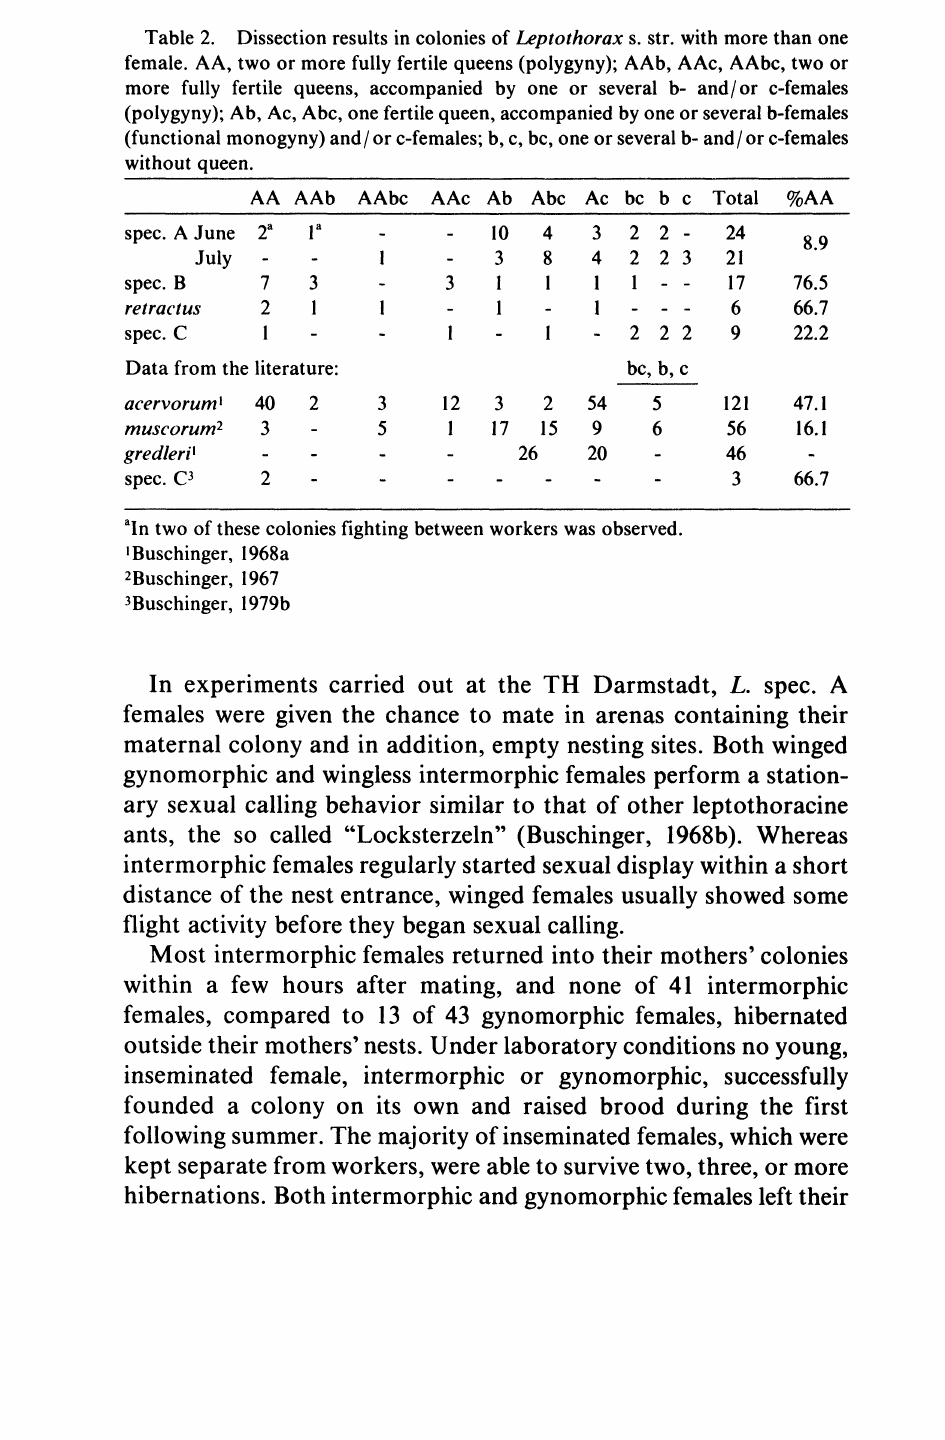
Psyche [Vol. 95 Table 2. Dissection results in colonies of Leptothorax s. str. with more than one female. AA, two or more fully fertile queens (polygyny); AAb, AAc, AAbc, two or more fully fertile queens, accompanied by one or several b- and/or c-females (polygyny); Ab, Ac, Abc, one fertile queen, accompanied by one or several b-females (functional monogyny) and/or c-females; b, c, bc, one or several b- and/or c-females without